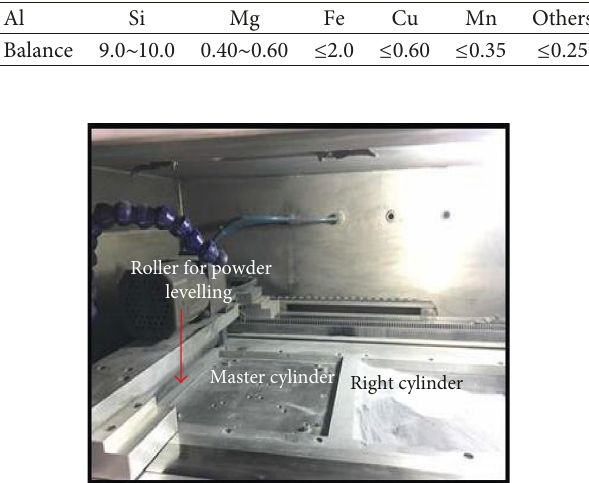
Figure 2: The SLM manufacturing